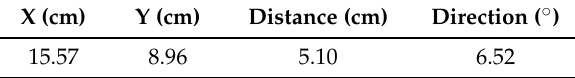
Table 3. RMSE of measurement experiment.